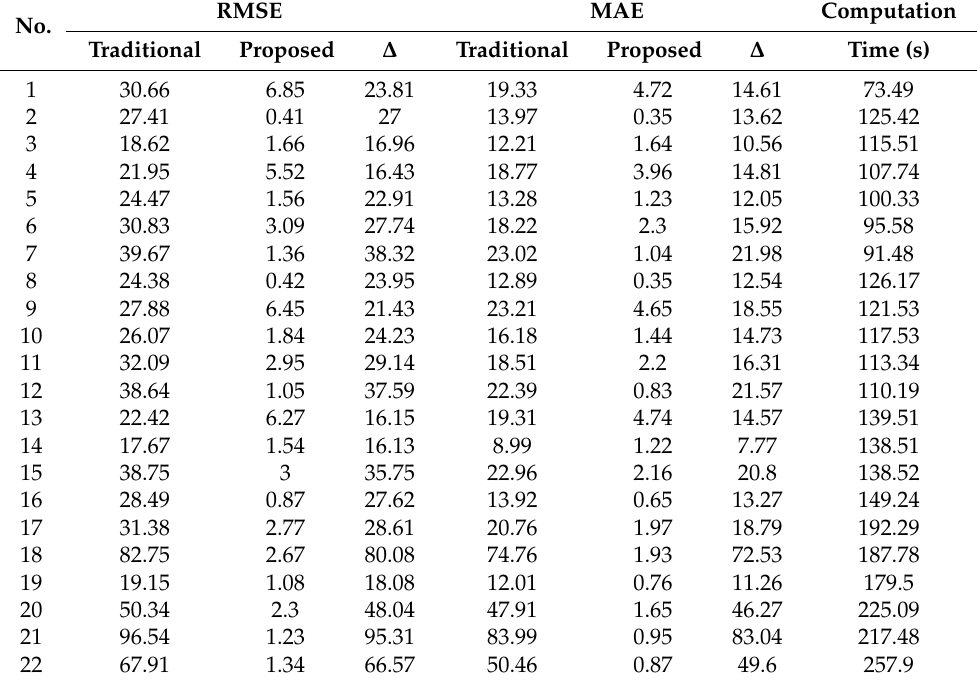
Table A4. Performance comparison for medium-term solar power forecasting (Winter) by the